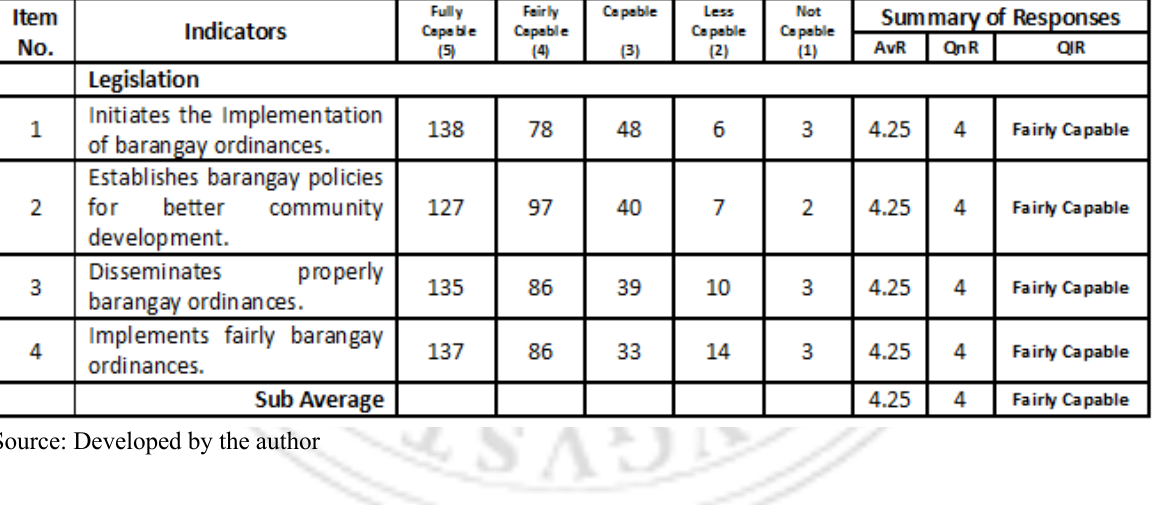
Source: Developed by the author